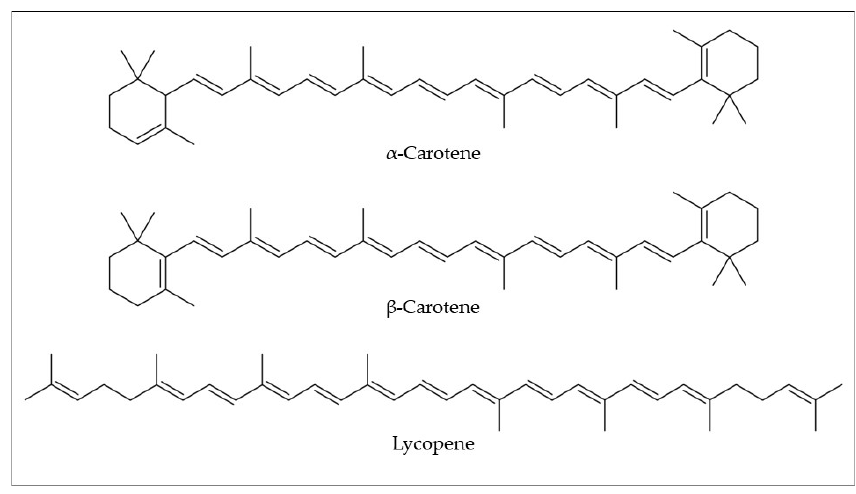
Figure 5. Chemical structures of the most common carotenoids found in araticum fruit. Own au- thorship created by ChemSketch software.